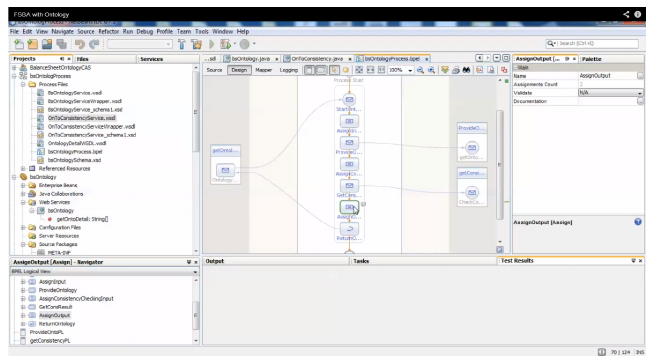
Figure 6. Implementation of Common Equity Tier 1 Capital Ratio